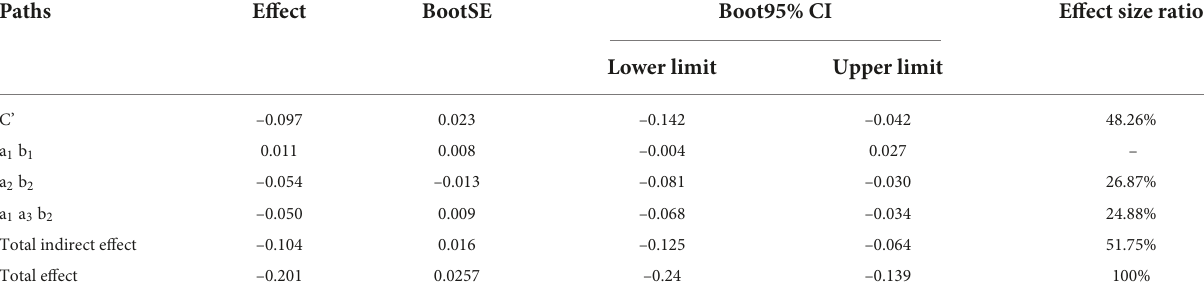
TABLE 5 Bootstrap analysis of the mediating effect test.